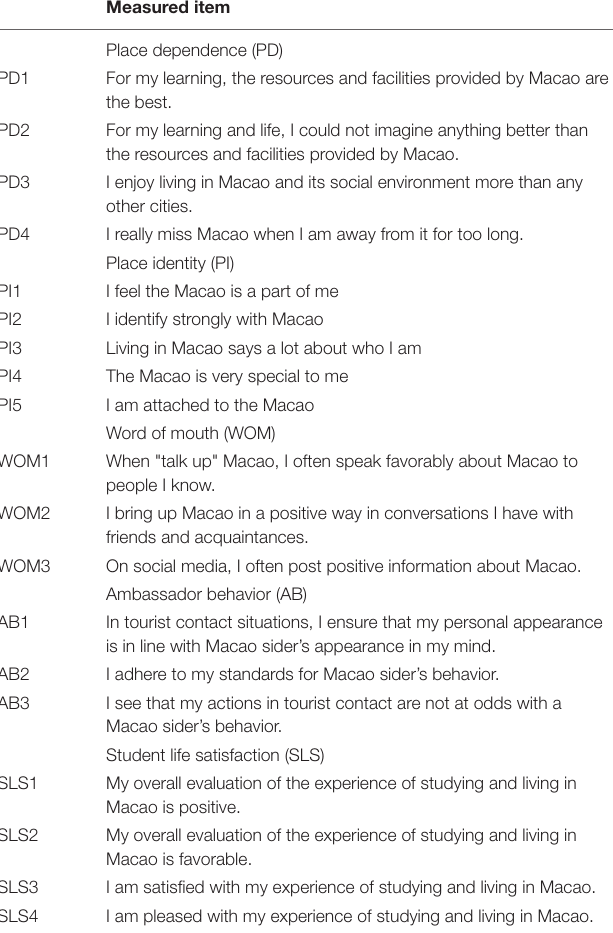
TABLE 1 | Measurement